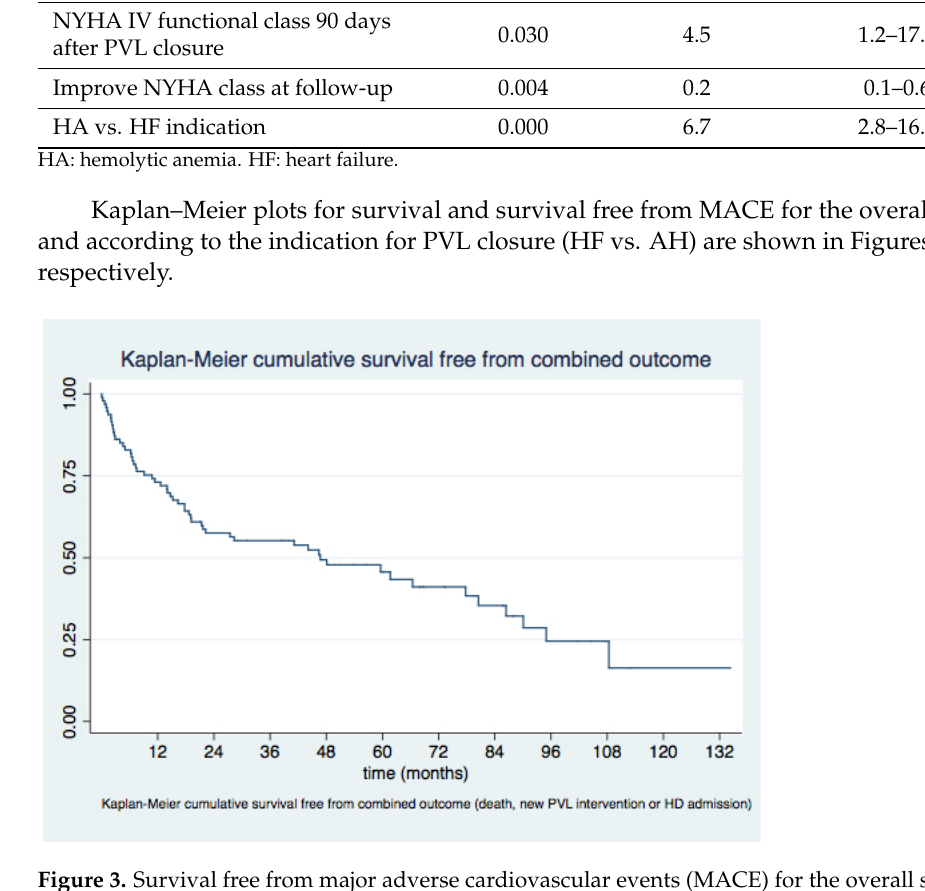
Figure 3. Survival free from major adverse cardiovascular events (MACE) for the overall sample.